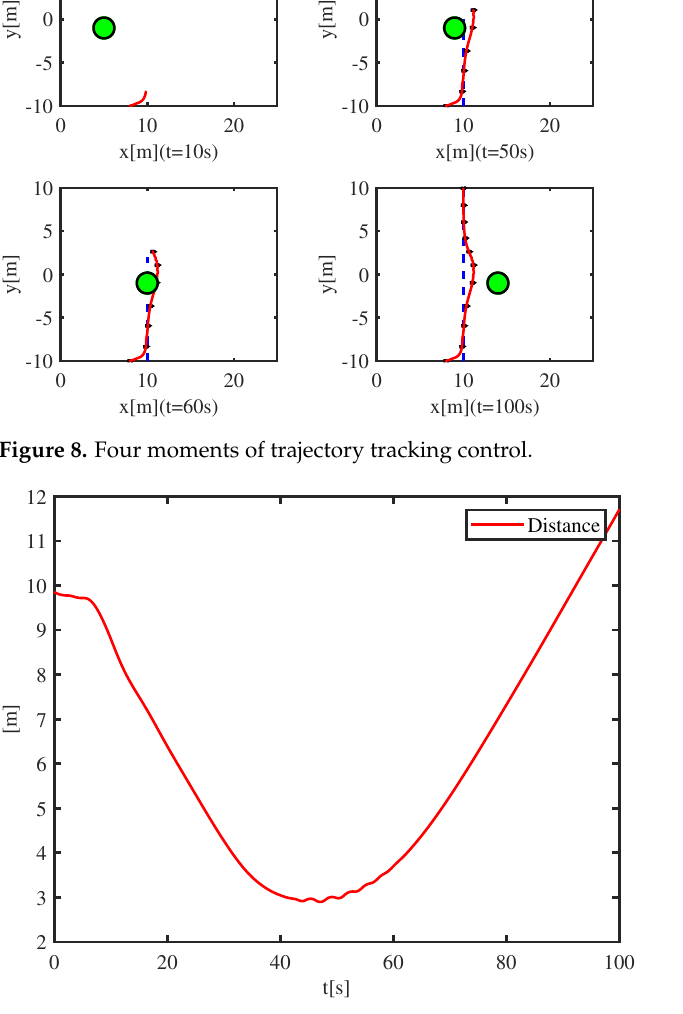
Figure 9. The distance between dynamic positioning vessel and non-cooperative ship.